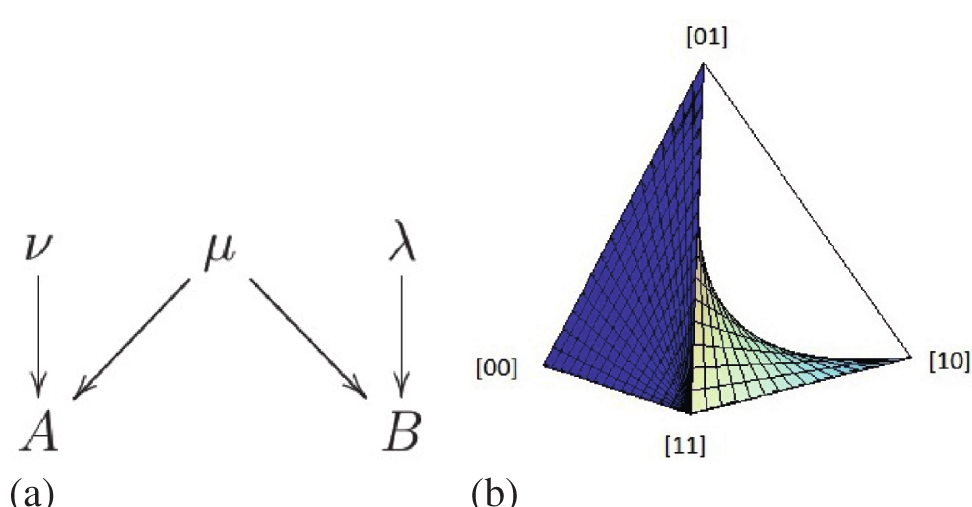
Figure 3 (a) u = uu and u = uu . (b) u